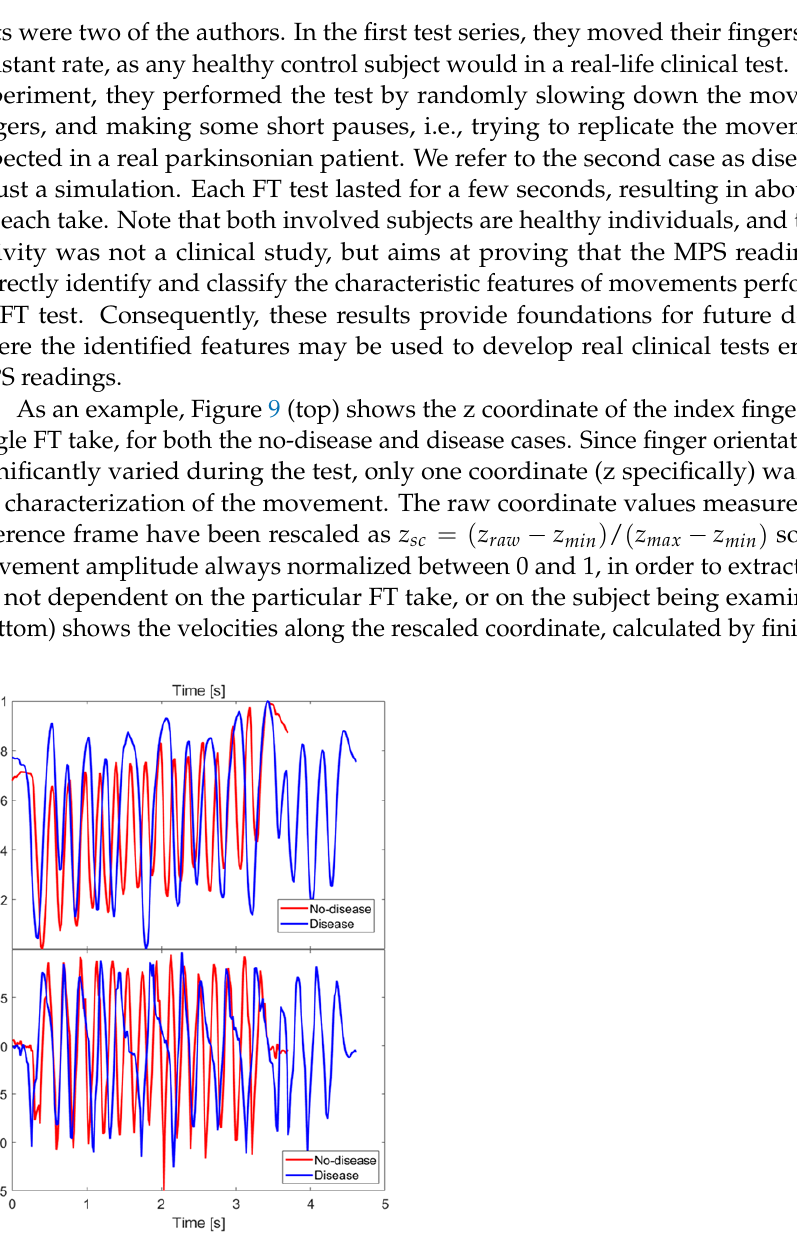
Figure 10. Frequency spectra of the z coordinate for both the disease and no-disease cases. The su- perposition of all spectra of each single FT take is shown, together with their average trend. The amplitudes are expressed in logarithmic units according to the following equa- tion: